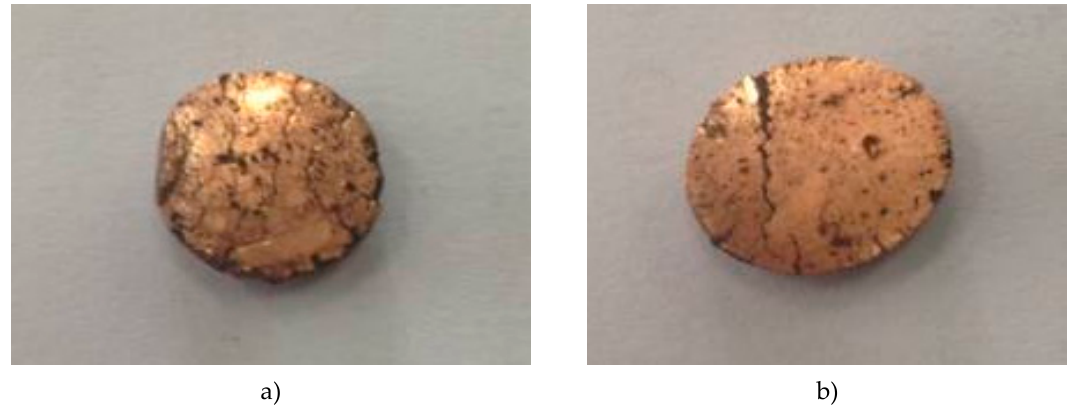
Figure 19. Images of Cu-5%Fe 3 O 4 ( a ) and Cu-15%Fe 3 O 4 ( b ) nanocomposites after cold rolling.